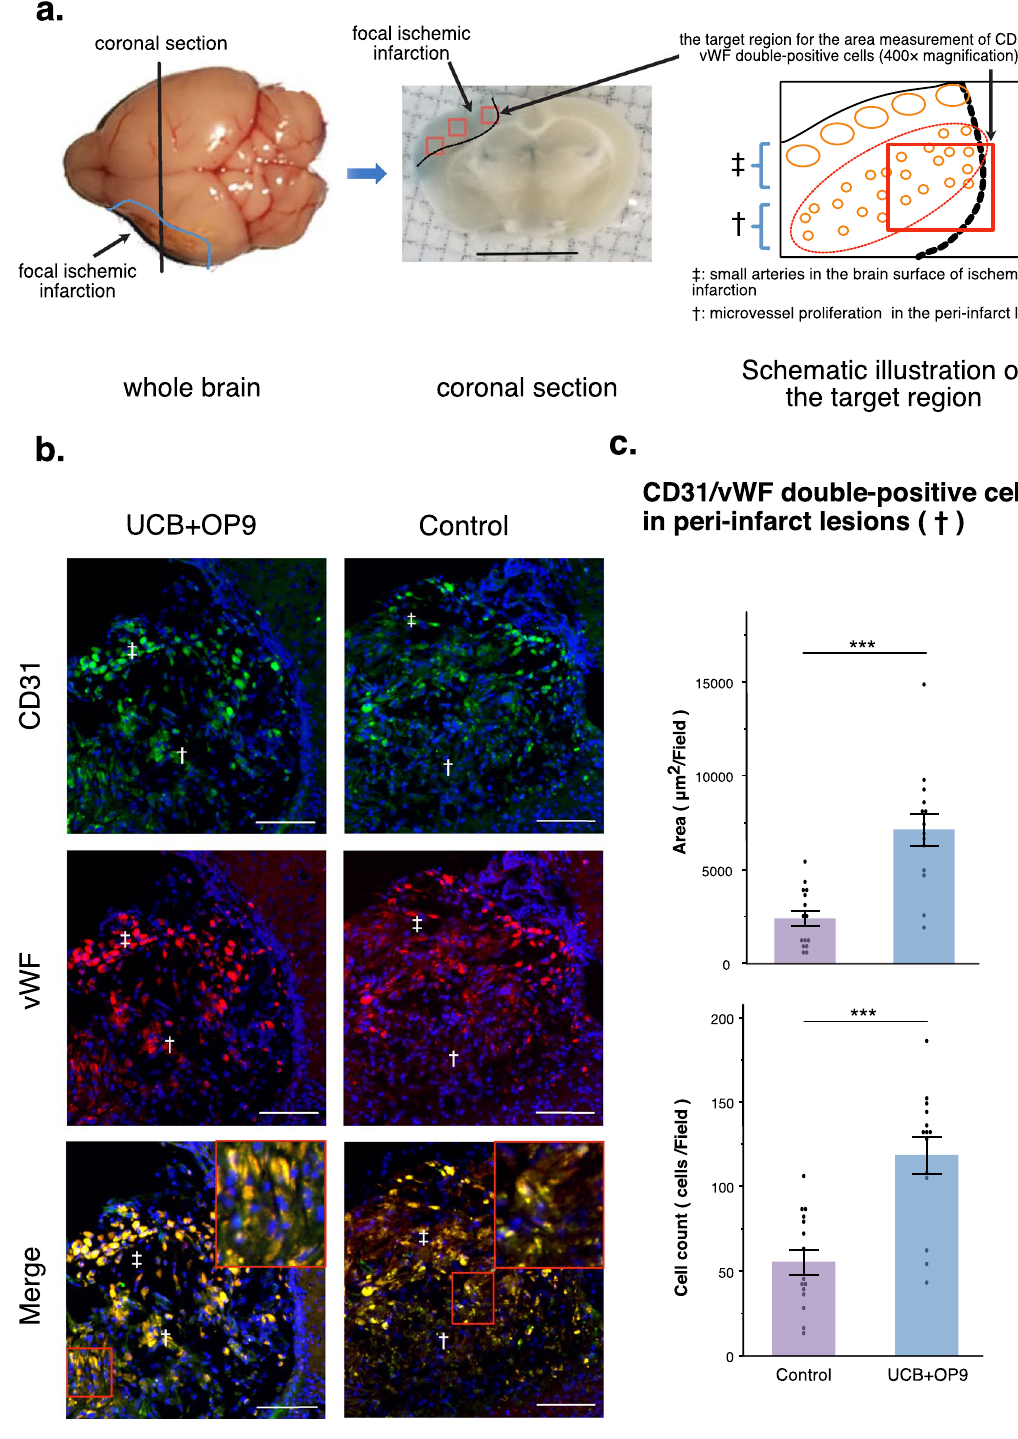
Figure 4. vWF and CD31 staining in the peri-infarct lesion of MCAO mice with or without OP9-pre-conditioned UCB administration. Fluorescent immunohistochemistry was performed 3.5 months after surgery (n = 5 in the UCB + OP9 group and n = 5 in the control group, respectively). ( a ) Schematic illustration of the target region for the area measurement of CD31/vWF (von Willebrand factor) double-positive cells by a fluorescence microscope. One coronal section per mouse (n = 5 in each group) was analyzed. Small arteries in the brain surface of ischemic infarction (‡) and microvessels in the peri-infarct lesion located at the periphery of the ischemic infarction adjacent to the normal cortex and striatum (†) were observed. Three non-overlapping random visual fields of (†) indicated by red solid boxes (400 × magnification) per coronal section were analyzed to measure the CD31/vWF double-positive area. ( b ) Representative images of immunofluorescent staining of brain sections. CD31/vWF double positive cells (yellow) with CD31 + (green) and vWF + (red) in the peri-infarct lesions (†) were subjected to the analysis in ( c ). Nuclei were counterstained using DAPI (blue). Scale bar: 50 μm. 200 × magnification. ( c ) The area measurement and cell count of CD31 + /vWF + cells per field observed in 400 × magnification (n = 15 per each group). ***p < 0.001, unpaired